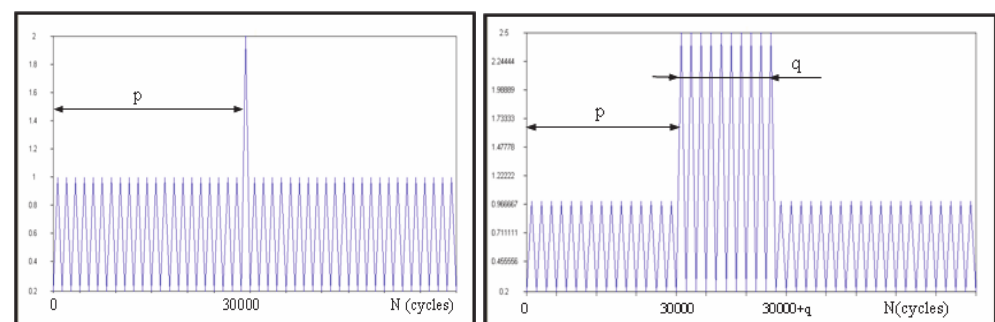
Figure 2: Applied spectrum form: (a) constant amplitude loading with single overload (b) with band overload.